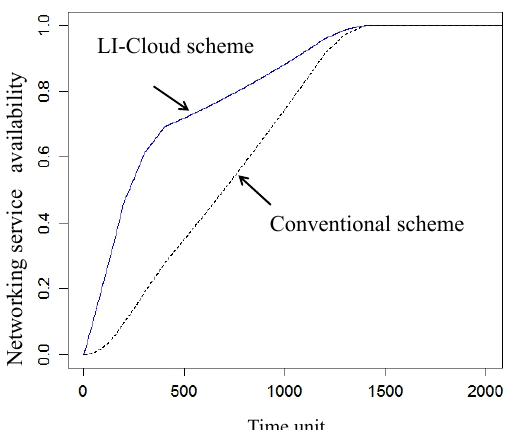
Figure 4. I-NSA for users in the scenario of parallel deployment of networking services with (uniform distribution of restoration. Ta, Tb, and Tc are set to 200, 300, and 400, and T AG , T BG , and T CG are set to 1200, 1300, and 1400, respectively).